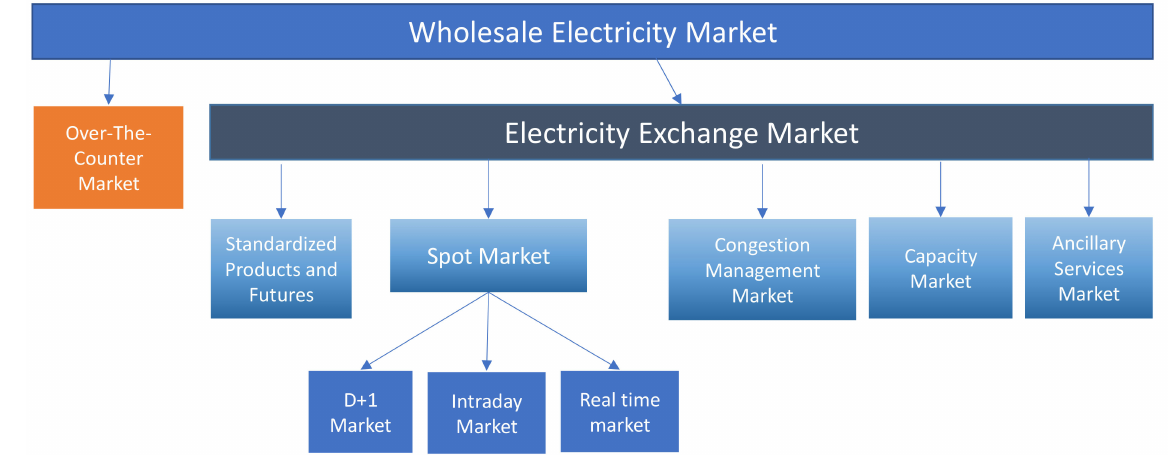
Figure 9. Competitive wholesale energy market (adapted from [85]).